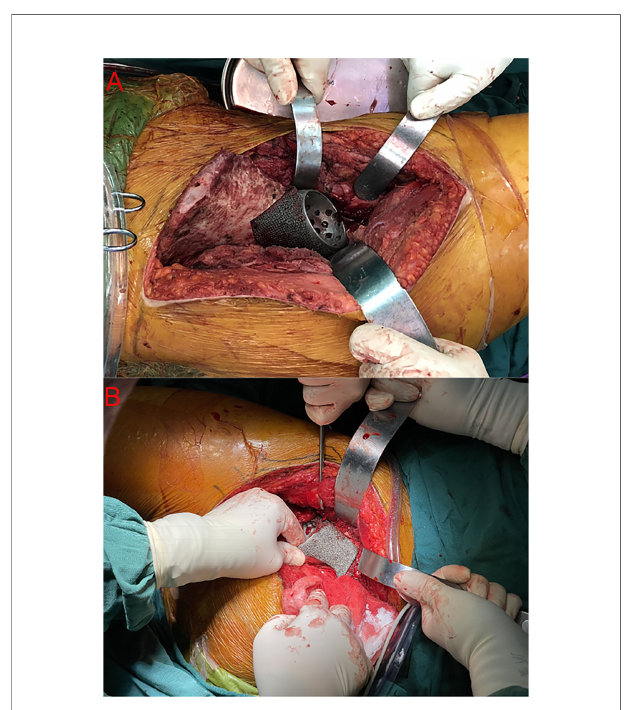
FIGURE 3 | Intraoperative photograph of the approaches: The intraoperative images show intimate contact between the host bone and 3D-printed custom-made endoprosthesis via the iliofemoral approach in patient 6 (A) and the modi fi ed Gibson approach in patient 17 (B)